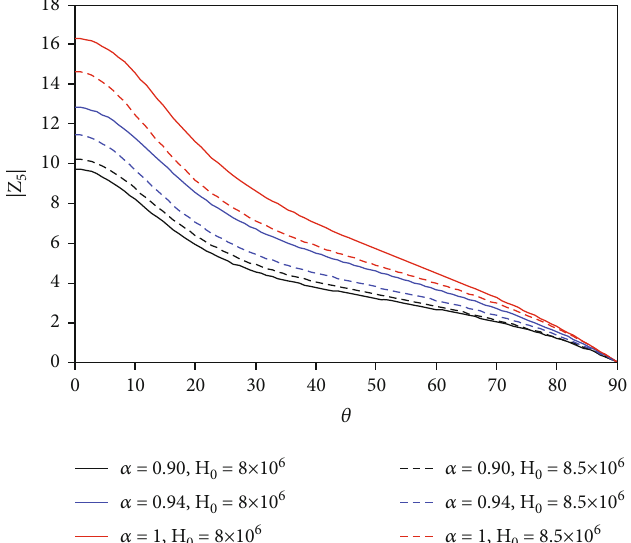
j concerning the angle of incidence θ for various values of the fractional parameter of the 5